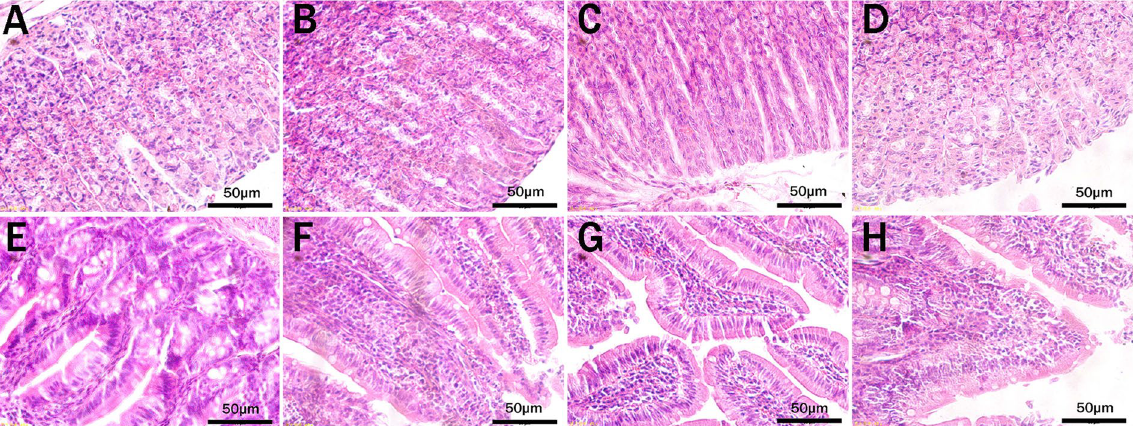
Figure 9. Morphology of rats’ gastric mucosa ( A – D ) and duodenum mucosa ( E – H ) after oral administration of physiological saline ( A , E ), NLR ( B , F ), NSR ( C , G ), NS ( D , H